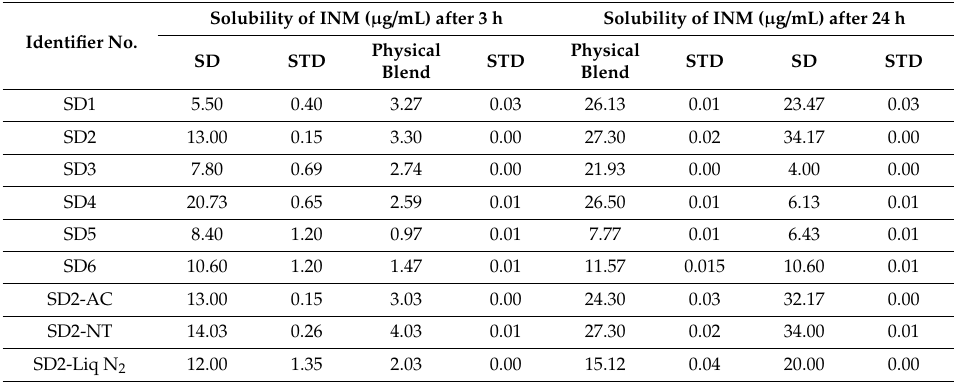
Table 8. Comparison of the aqueous solubility of INM and standard deviation (STD) from various quaternary and ternary SD formulations and physical blends in pH bu ff er 1.2 after 3 and 24 h respectively. Physical blends contain crystalline